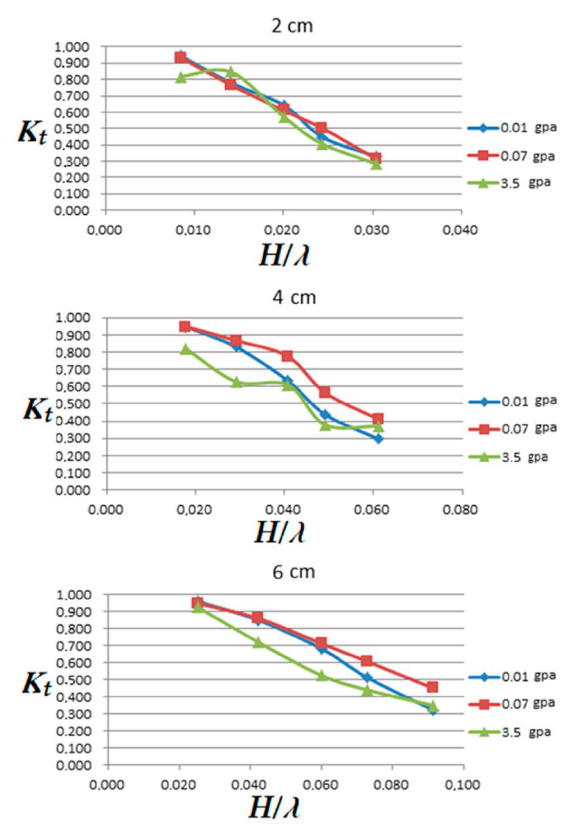
Figure 13. The relationship between the wave steepness and transmission coefficient of different elastic plates when the wave height is 2, 4 and 6 cm at a fixed water depth 0.3 m.